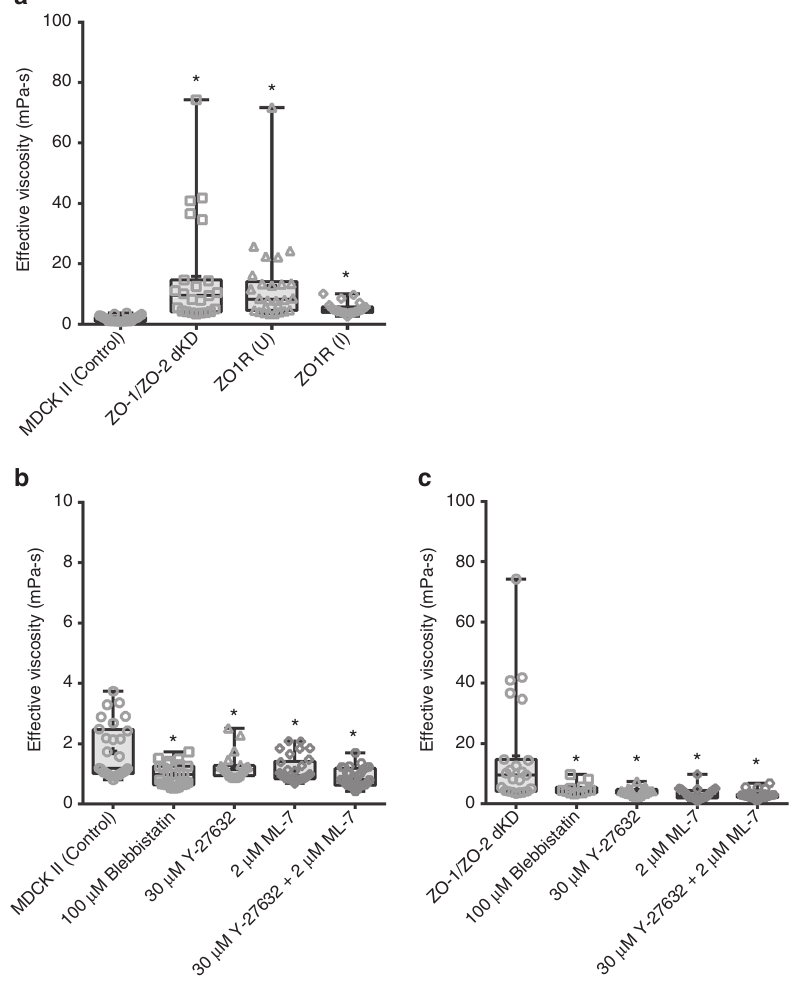
Fig. 5 Apical surface effective viscosity is elevated in ZO-1/ZO-2 dKD polarized epithelium and additional actomyosin perturbations signi fi cantly modify